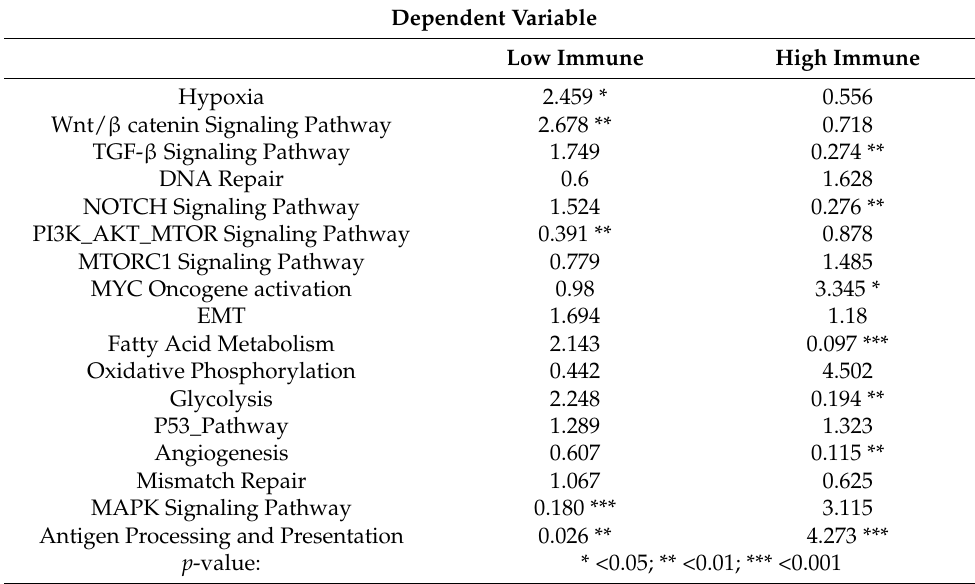
Table 1. Result of multinomial logistic regression in melanoma TCGA sample.